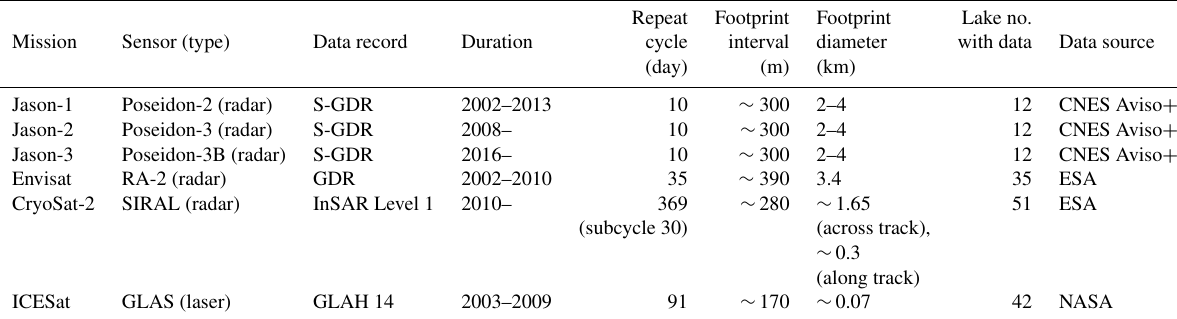
Table 2. Multisource altimetry data used in this study.